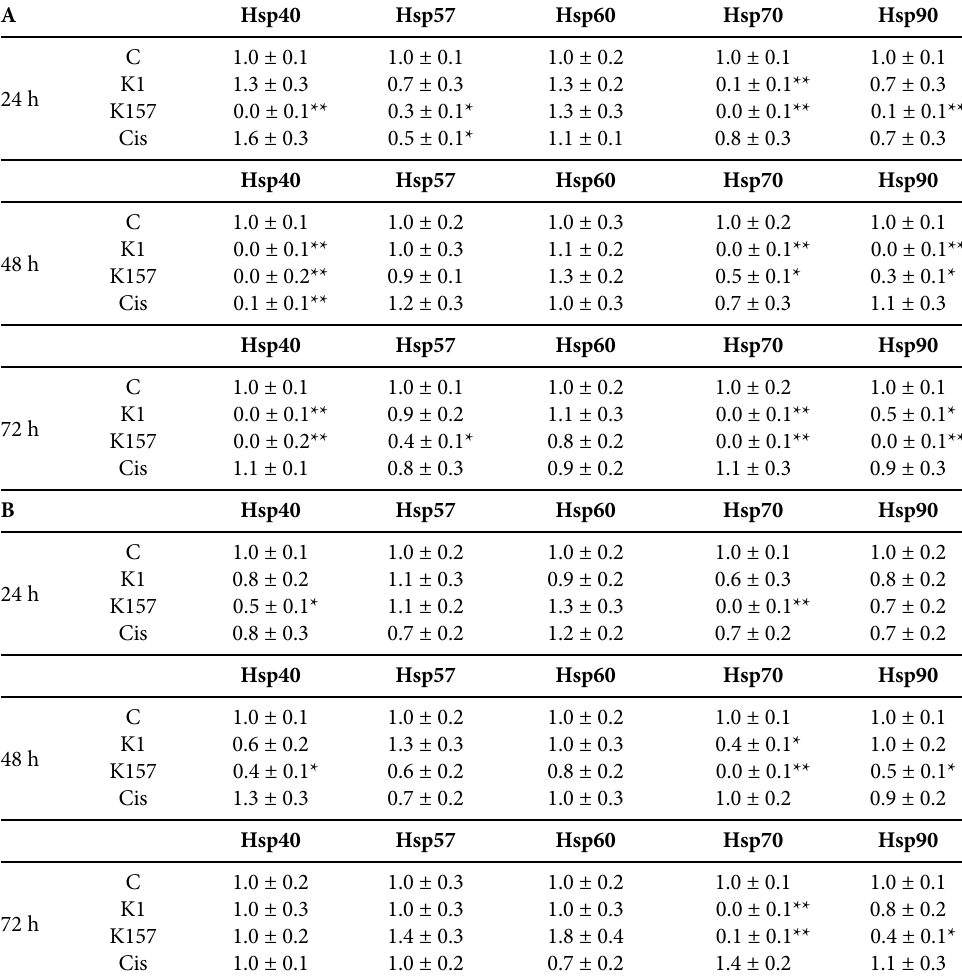
Table I. Effects of IC50 concentrations of homobrassinin (K1), thiazino[6,5-b]indol (K157), and cisplatin (Cis) on HSP40, HSP57 (PDI), HSP60, HSP70, and HSP90 in A2780 (A) and A2780cis (B) cell lines. Ratios ± standard devi- ation from quantitative densitometric analysis of HSP40, HSP57, HSP60, HSP70, and HSP90 were normalized to α-tubulin. Ratios at untreated control (C) were arbitrarily set to 1. *p<0.05; **p<0.01 vs. C (three independent exper- iments; one-way ANOVA